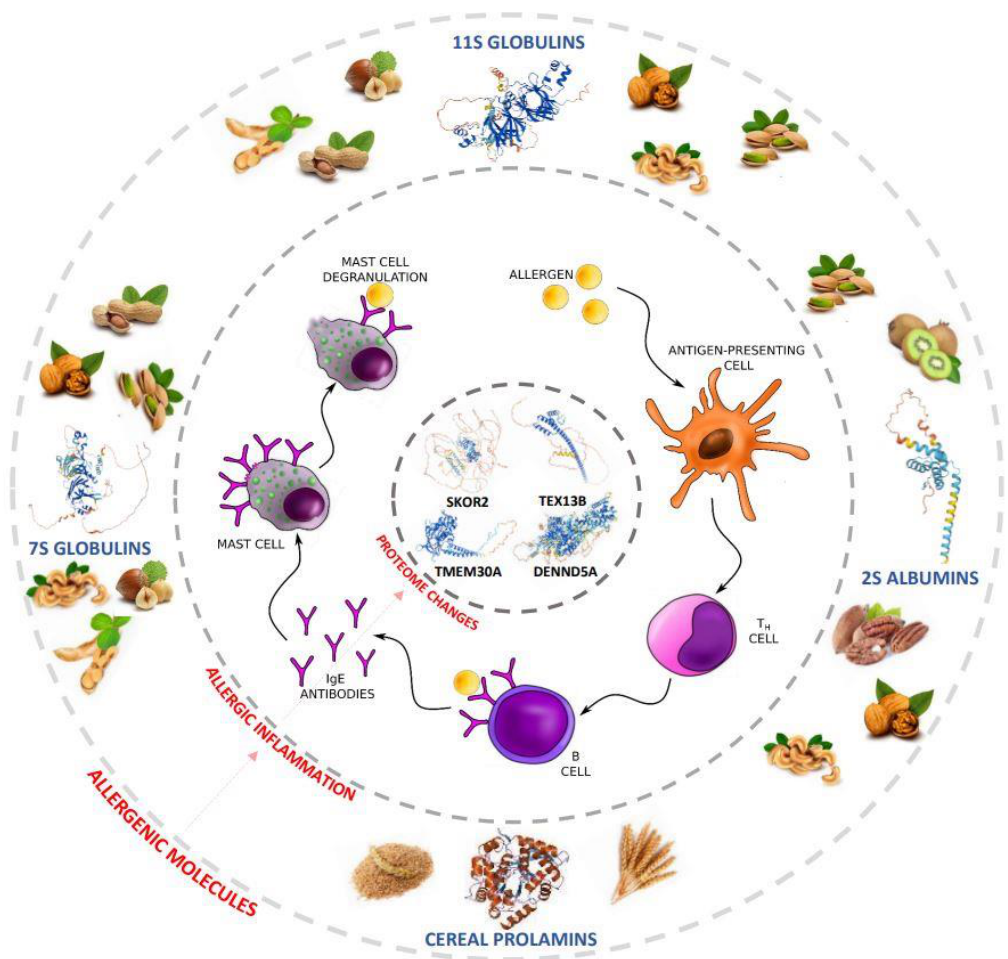
Figure 6. A cascade of molecular changes driven by plant storage proteins. SKOR2-SKI family transcriptional corepressor 2; TEX13B-testis-expressed sequence 13B; TMEM30A-P4-ATPase flippase complex beta subunit TMEM30A/transmembrane protein 30A/cell cycle control protein 50A (CDC50A); DENND5A-DENN domain-containing protein 5A.